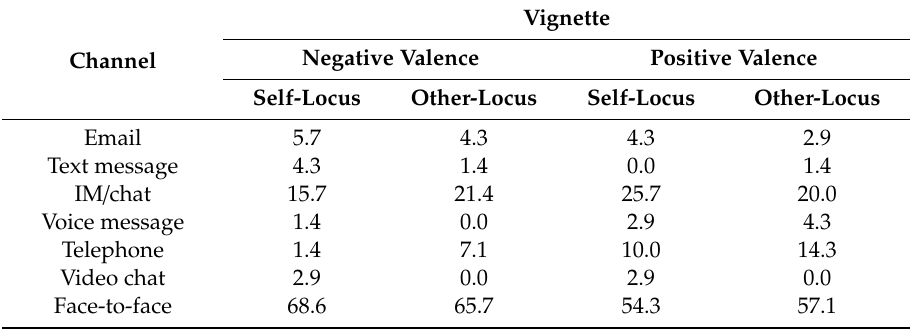
Table 1. Relative frequencies [% of column] of channel choice for each